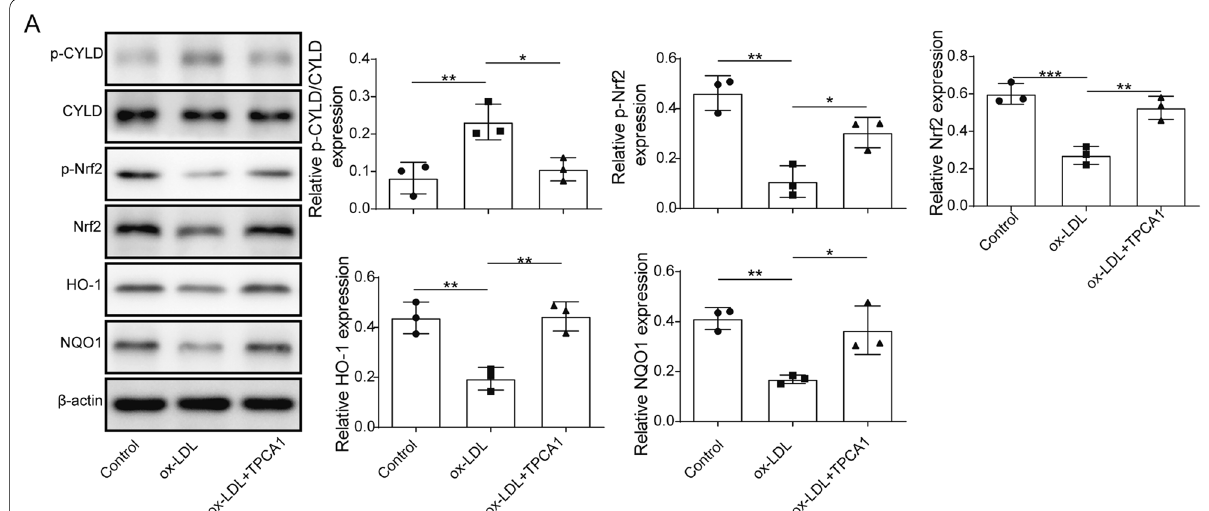
Fig. 4 IKK promoted oxidative stress injury caused by obesity through CYLD phosphorylation. The protein levels of p‑CYLD, CYLD, and p‑Nrf2. Nrf2, HO‑1 and NQO1 were measured using western blotting in treated HK‑2 cells. IKK, IκB kinase; CYLD, cylindromatosis; Nrf2, NF‑E2‑related factor 2; HO‑1, haem oxygenase 1; NQO1, NAD(P)H dehydrogenase quinone 1; HK‑2, human kidney 2. Significance was assessed by an ANOVA test. The experimental data are shown as the mean SD. N 3. *P < 0.05, **P < 0.01, ***P < ± =